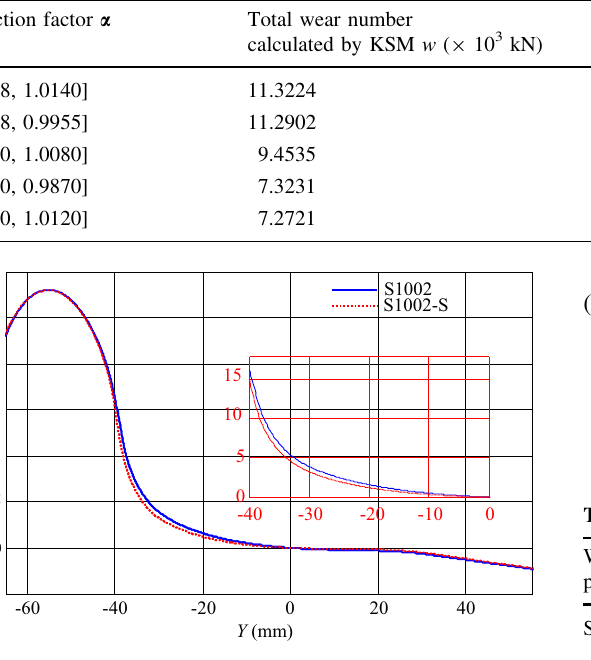
Fig. 13 Comparison between the S1002 and S1002-S profiles